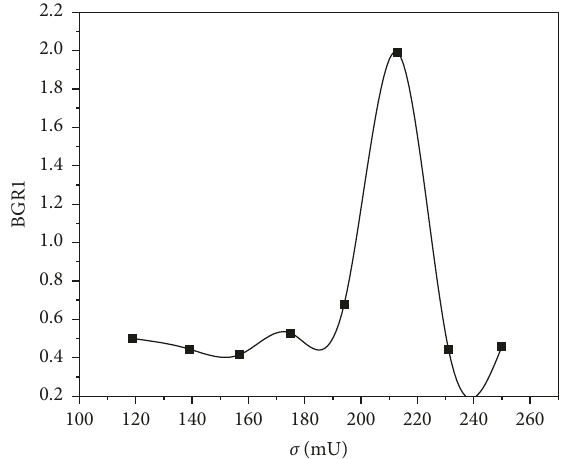
Figure 5: Group B under low-intensity aerobic exercise.